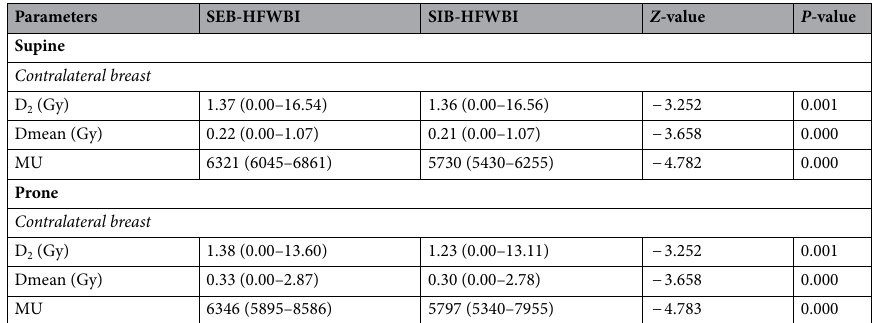
Table 5. Dosimetric evaluation for the contralateral breast and MU between the SEB-HFWBI and SIB- HFWBI treatment plans in the same position (median). SIB simultaneous integrated boost, SEB